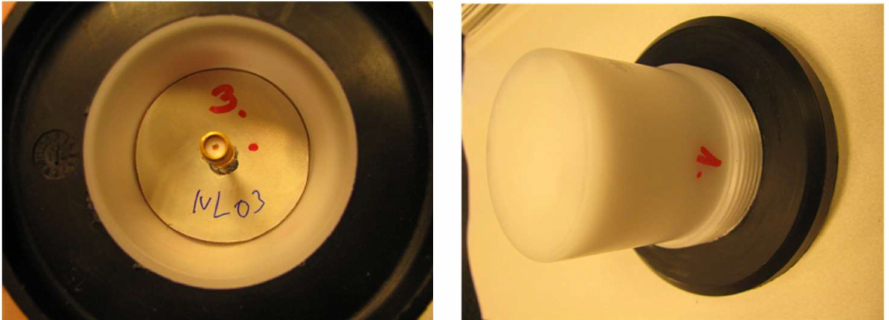
Figure 24. Microstrip antenna connector and radome.